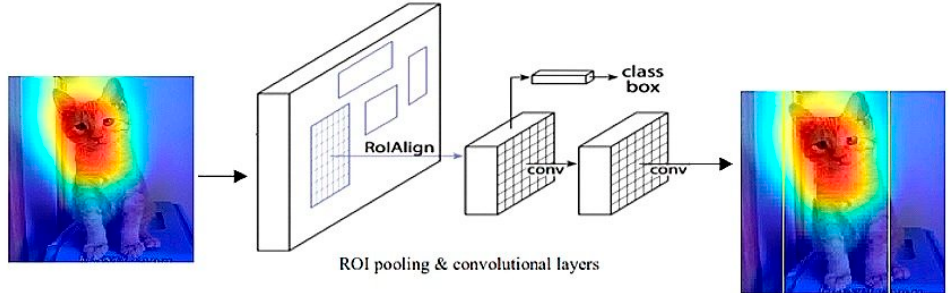
Figure 2. Mask R-CNN for object detection [19].